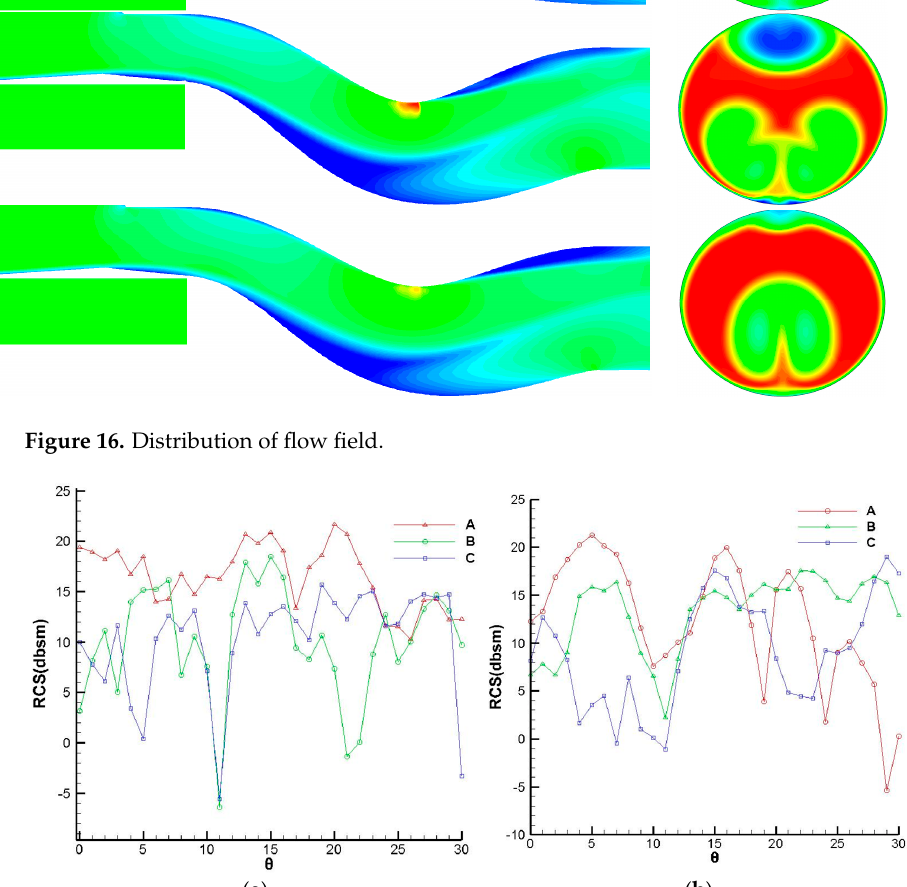
Figure 17. RCS in the vertical direction. ( a ) Horizontal polarization ( b ) Vertical polarization.